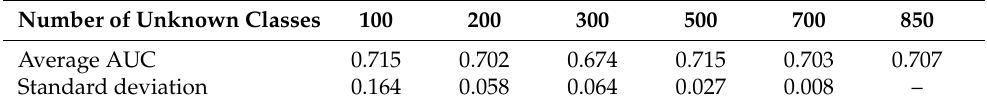
Table 5. AUC performance on ImageNet trained on 150 known classes and tested on various unknown classes. The classes were randomly chosen ten times, except when all of them were used (rightmost